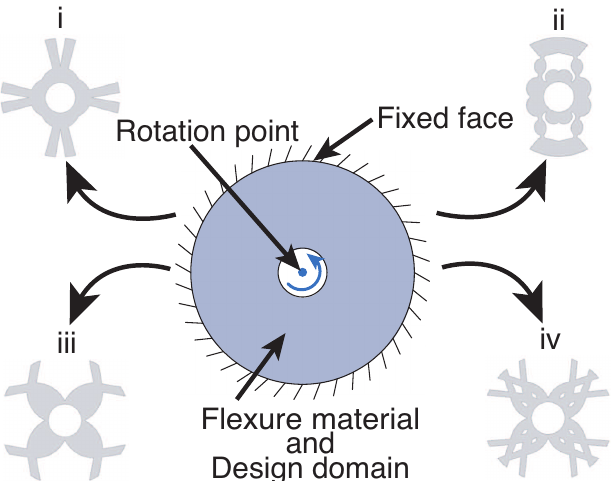
Figure 16. Schematic description of the Topology Optimization process to design the optimal configuration of SARFJ using a 2D design domain based on the geometry of compliant revolute